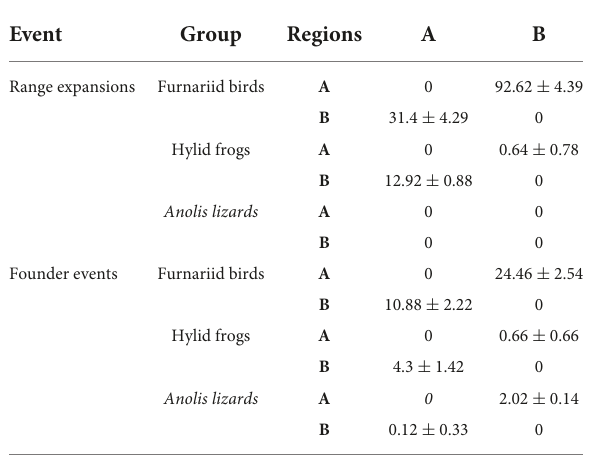
et al. (2017) demonstrated that open areas exhibit higher net diversification rates than forested areas ( Table 3 ). For